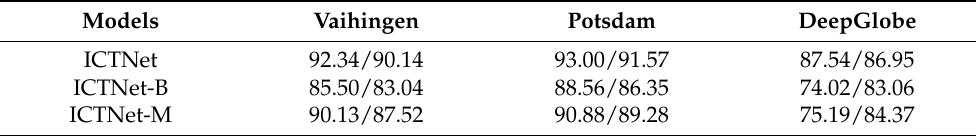
Table 6. Results of the ablation study of DUP. The accuracy is in the form of mean F1-score/OA. Models